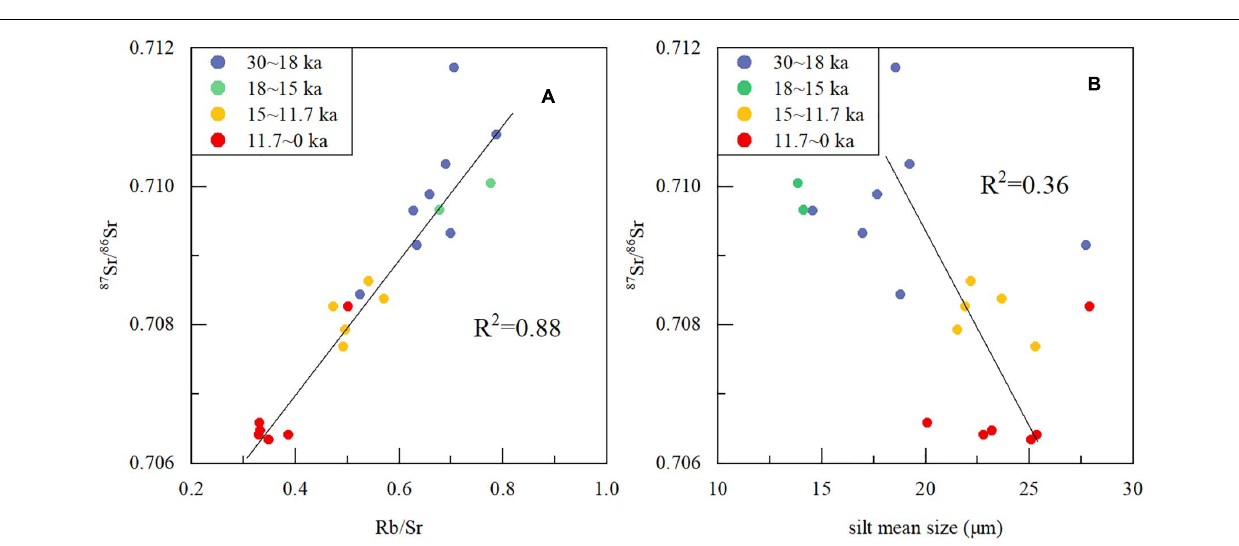
FIGURE 7 | Plots of correlations among 87 Sr/ 86 Sr, Rb/Sr (A) , and silt mean size (B) in core